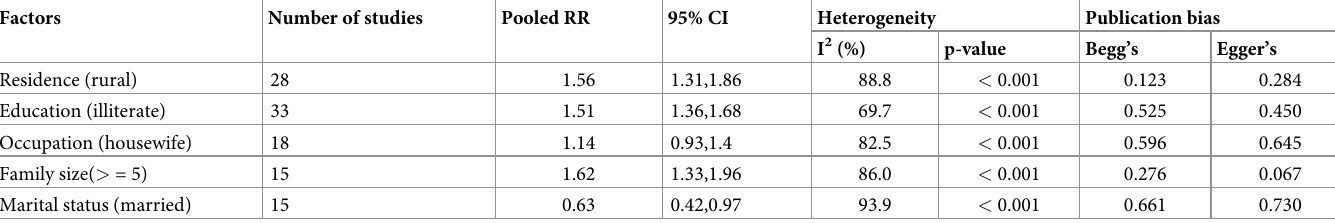
Table 3. Association of socio-demographic factors with anemia among pregnant women in